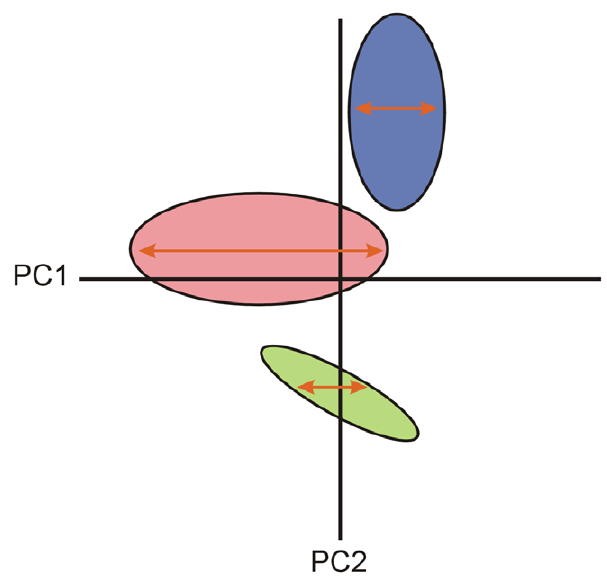
Figure 1. In a common morphospace, major axes of morpho- logical diversity may still differ among groups of interest. Ordered axis plots may not be able to discriminate between patterns of morphological diversity along axes of a multidimensional morphospace because of its reliance upon principal components analysis and the inherent biases of this method. Here the aspects of diversity parallel to PC1 are highlighted with a red arrow for each group of interest. Note that the length of most variable group (pink) is parallel to PC1 because it has the greatest influence over the determination of PC1 in this common morphospace. Other less variable groups (blue, green) have less influence over the trajectory of PC1, but still possess variation that lies parallel to PC1. However the greatest axis of variation within these less variable groups may lie along a vector that differs from PC1. Without knowing a priori whether axes of variation among distinct groups are similar, it is impossible to know the degree to which an ordered axis plots approach will yield misleading results.